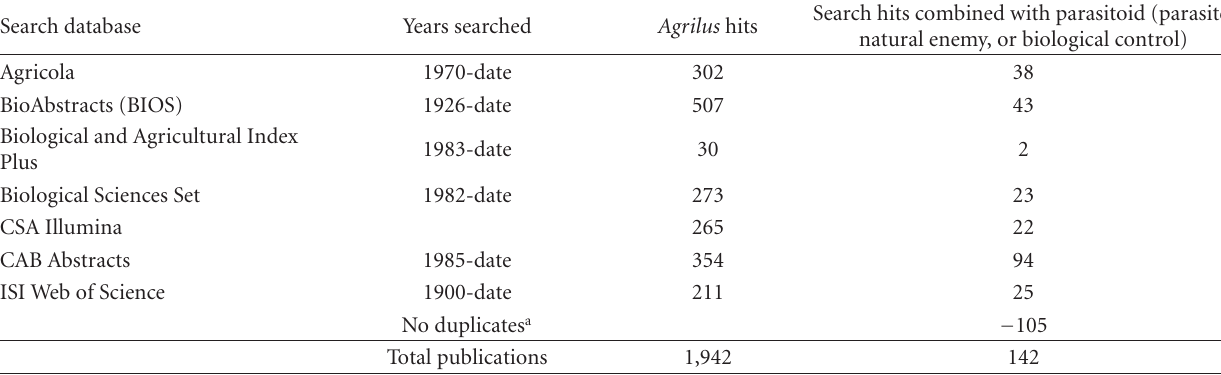
Table 1: Summary of online database search for Agrilus and associated